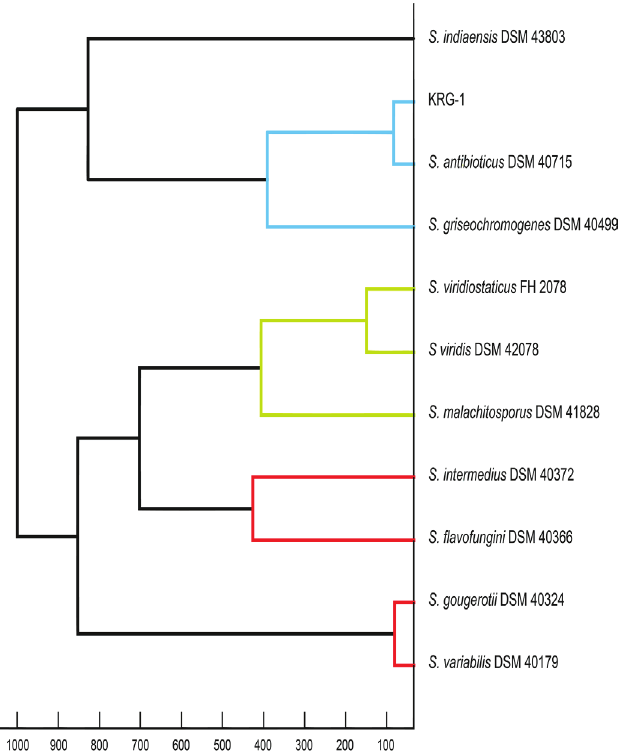
FIGURE 2 - MSP dendrogram of isolate KRG-1 based on the protein spectra with local Streptomyces database of type